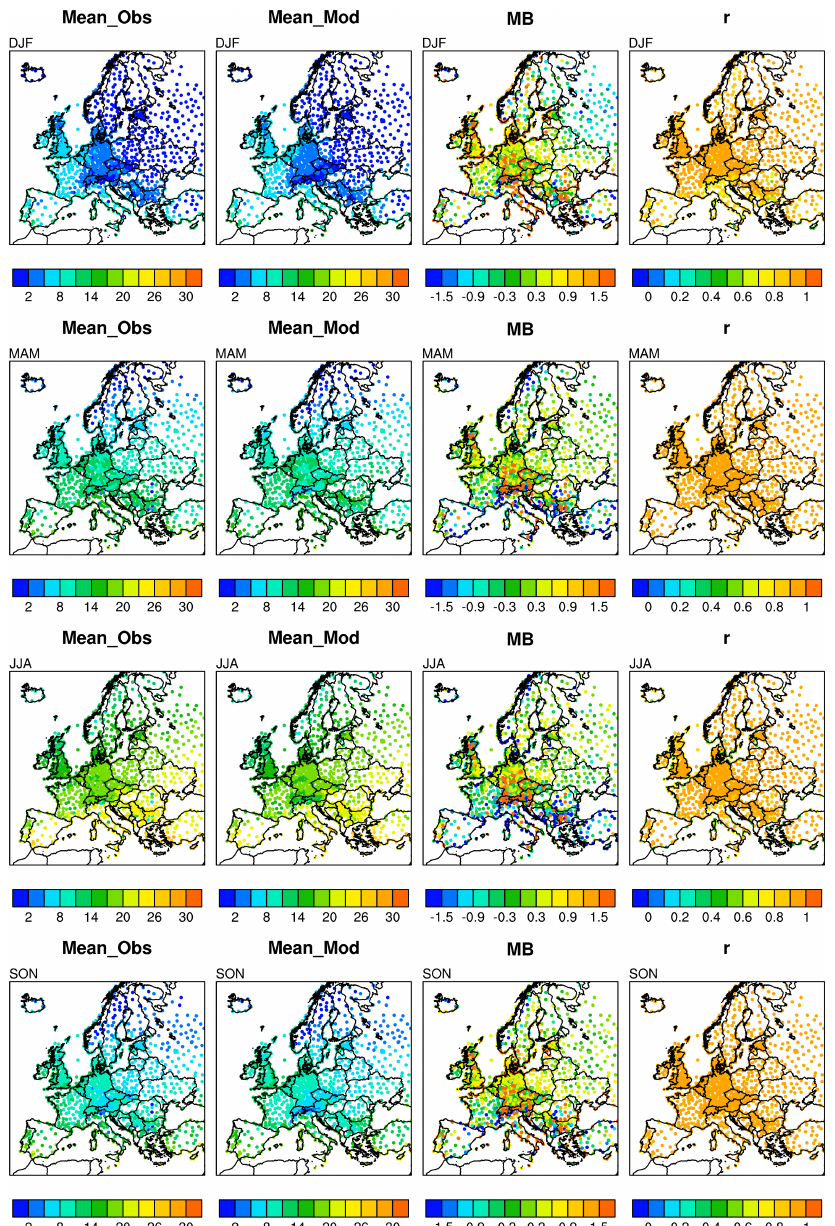
Figure 1. Seasonal average values of 2m temperature (T2) in ◦ C. Model results and statistics are shown for the MOZART simulation at the locations of the